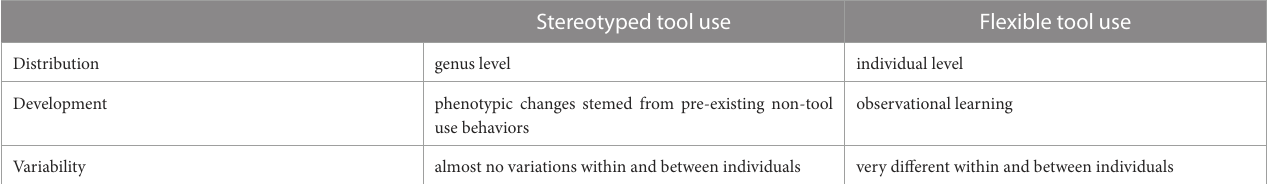
TABLE1 ComparisonofstereotypedtooluseandflexibletoolusebasedonHunt et al.(2013)’sdescriptions.